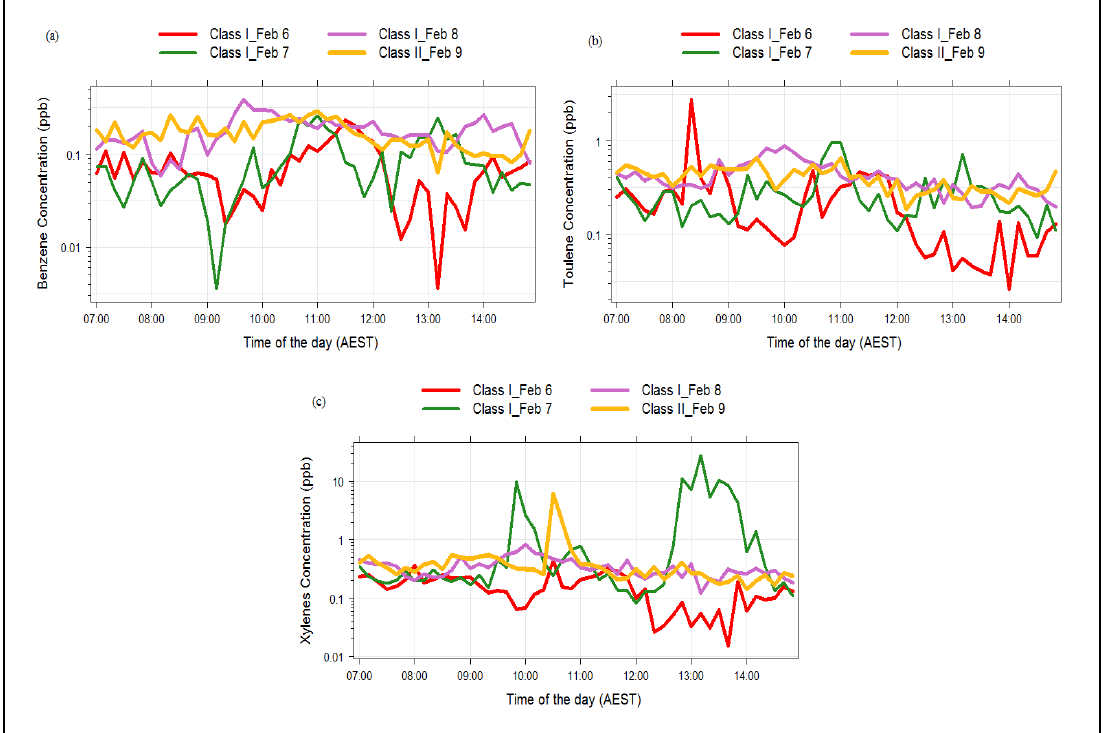
Figure 8. Time series of the ( a ) benzene, ( b ) toluene and ( c ) xylenes concentrations on the four consecutive days (6, 7, 8 and 9 February 2013). 6, 7 and 8 February were the Class I event days, and 9 February 2013 was the selected Class II event day. Only measurements from 6:00–15:00 are plotted. Note that y-axes are in log-format. Ten-minute averaged data were